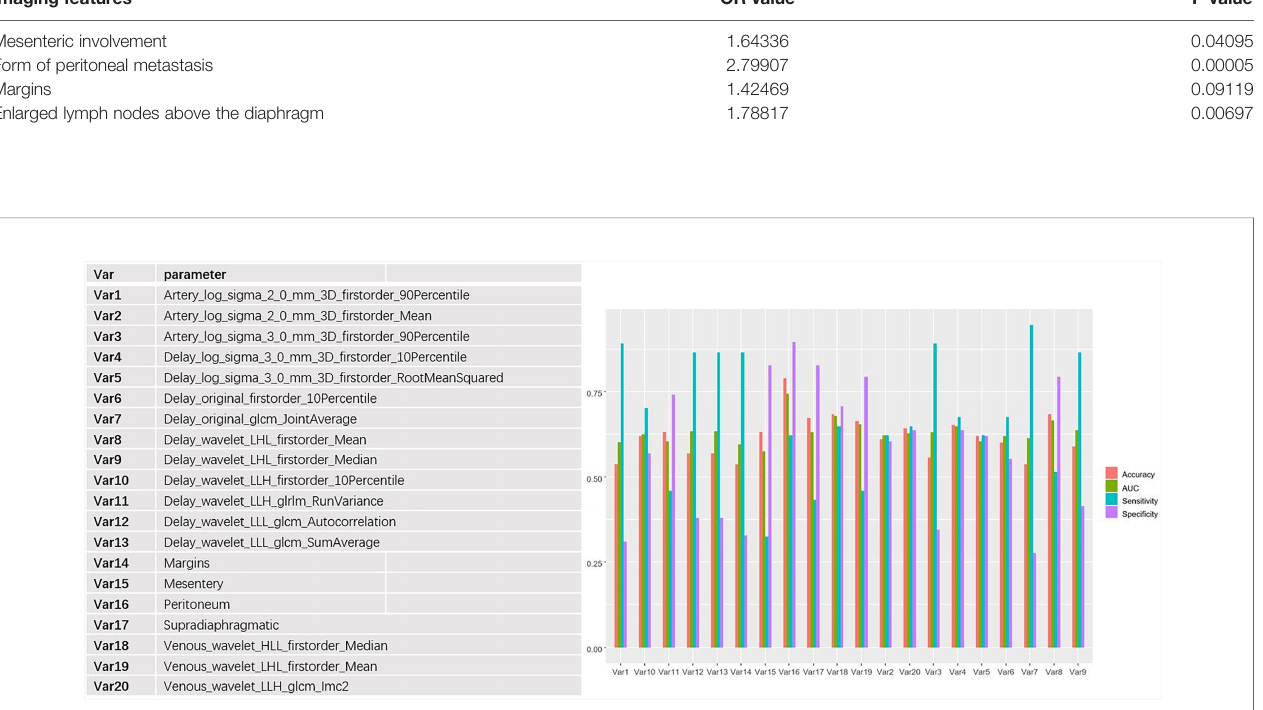
FIGURE 4 | Independent predictive ef fi cacy of the 20 features with the best performance (including CT imaging features and texture features), among which the peritoneal transition form had the best diagnostic ef fi cacy, with AUC, accuracy, speci fi city, and sensitivity of 0.74, 0.79, 0.90, and 0.62,